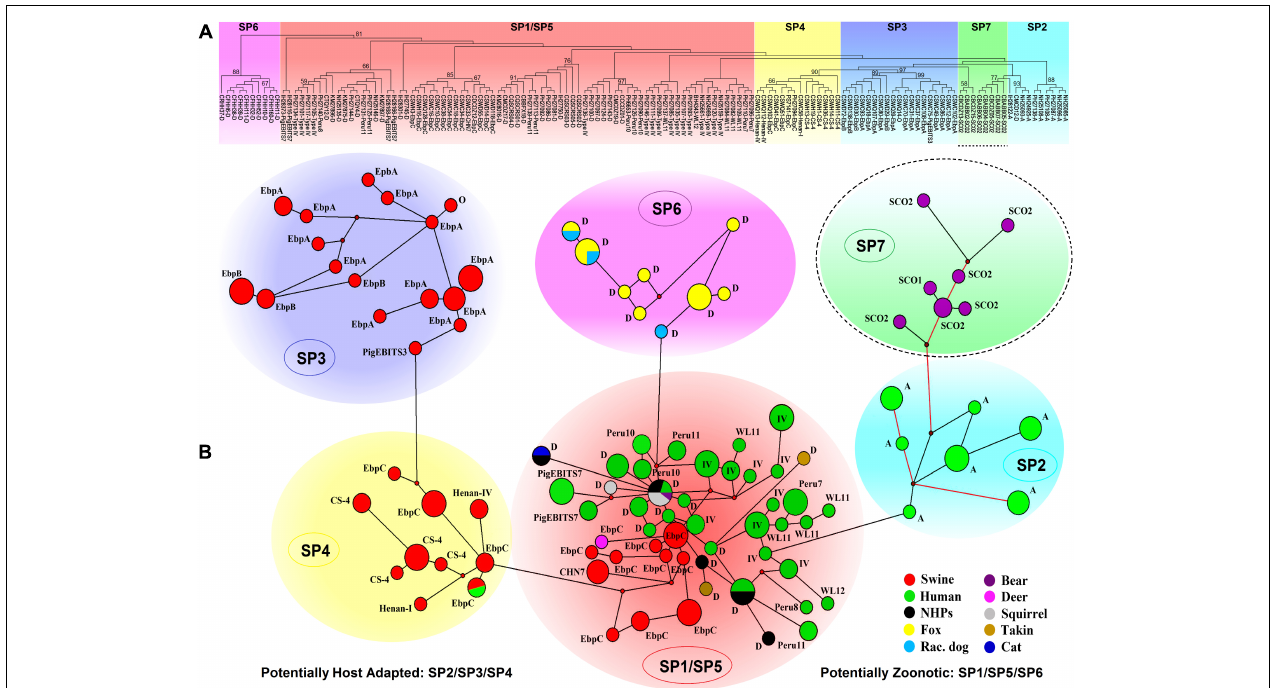
FIGURE 2 | Multilocus phylogeny and haplotype network of Enterocytozoon bieneusi ITS Group 1 isolates sampled in various hosts and locations. All the E. bieneusi isolates ( n = 246, Supplementary Table S2) that were previously genotyped as Group 1 members were included in the analyses except for five isolates (2 for genotype IH and 3 for genotypes D, horse1, and Nig2) with multilocus sequences significantly divergent from the other Group 1 members. The naming of subpopulations is based chiefly on that described previously (Wan et al., 2016). SP7 is highlighted with a dashed border as its host specificity and zoonotic potential are poorly understood. Panel A : Maximum-parsimony phylogeny of 138 unique multilocus genotypes (MLGs) generated considering both single-nucleotide polymorphisms (SNPs) and insertions and deletions from the total isolates using Mega 7 (http://www.megasoftware.net/). The first initials of isolate names, B, C, I, K, N, and P, indicate the isolates were sampled in Brazil, China, India, Kenya, Nigeria, and Peru, respectively. The letters B, C, D, F, H, M, Q, R, S, and T followed indicate the isolates were sampled from bear, cat, deer, fox, human, monkey, squirrel, raccoon dog, swine, and takin, respectively. ITS genotypes are labeled at the ends. Bootstrap values (1,000 replicates) above 50% are shown at the nodes. Panel B : Genetic network analysis of all the 246 isolates using the median-joining method implemented in Network 4.6.1.1 (http://www.fluxus-engineering.com/sharenet_rn.htm). The colors in circles correspond to different hosts sampled. The size of the circles is proportional to the frequency of each of the 98 MLGs obtained with consideration of only SNPs. ITS genotypes are labeled beside the circles. Genotype type IV is abbreviated as IV for better presentation and non-human primates as NHPs likewise. The branches connecting MLGs have a length proportional to the number of SNPs, while the red branches having pairwise differences above 12 SNPs are shortened for better